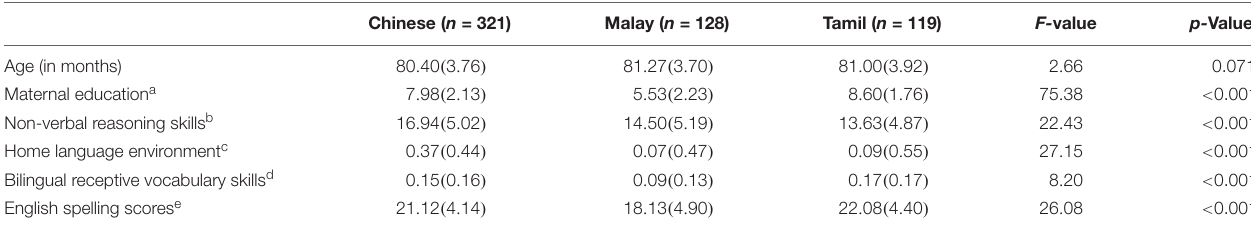
TABLE 1 | Children’s background information across the three Asian language groups ( N =